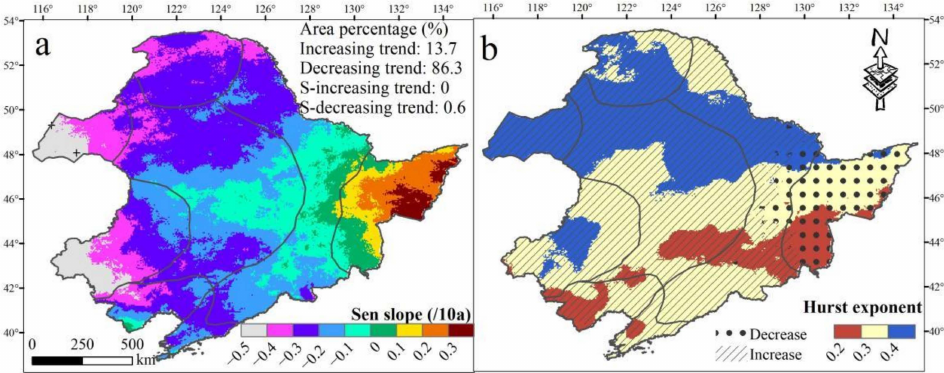
Figure 6. Spatial variation trends of SPEI12 ( a ) and spatial distribution of Hurst exponent value of SPEI12 ( b ) in northeast China from 1990 to 2018. S- in the figure is the abbreviation for significant. Black crosses indicate significant trends with p < 0.05.